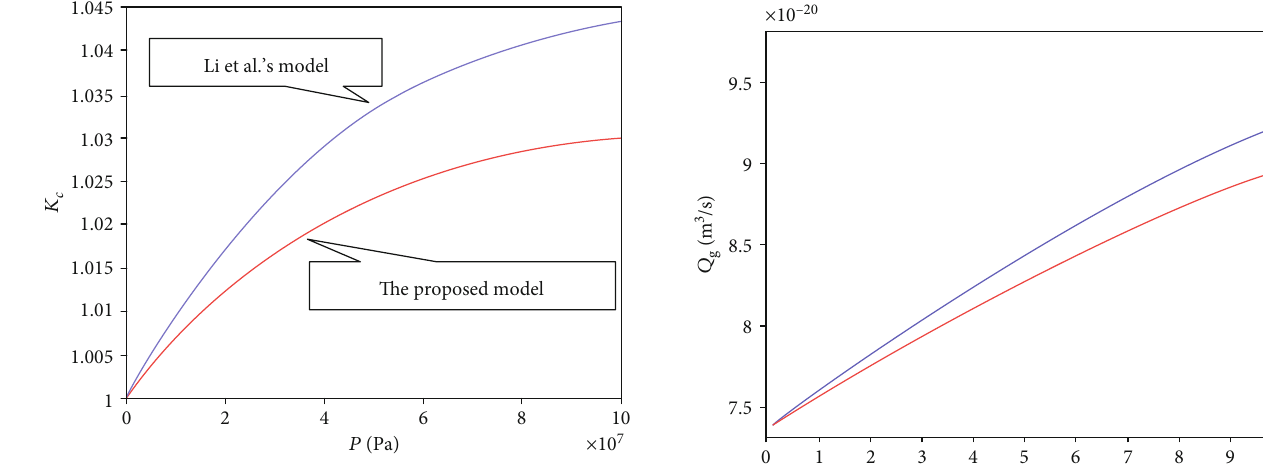
= 0 : 7nm , h = w m Figure 8: Comparison of gas fl ow rate Q with Li et al. ’ s model [22]. g T = 300 K, h = 0 : 7 nm , h = 0 : 3nm , r = 5nm , L = 0 : 0723 w m 0 m, θ = 30 °